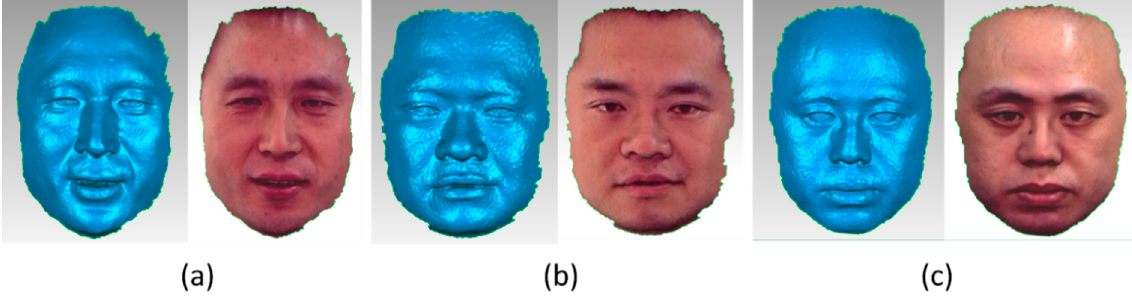
Figure 15. ( a – c ) Three-dimensional reconstruction results of different real faces with N = 12 the speckle stereo image pairs: a contrast display of textured and non-textured maps.